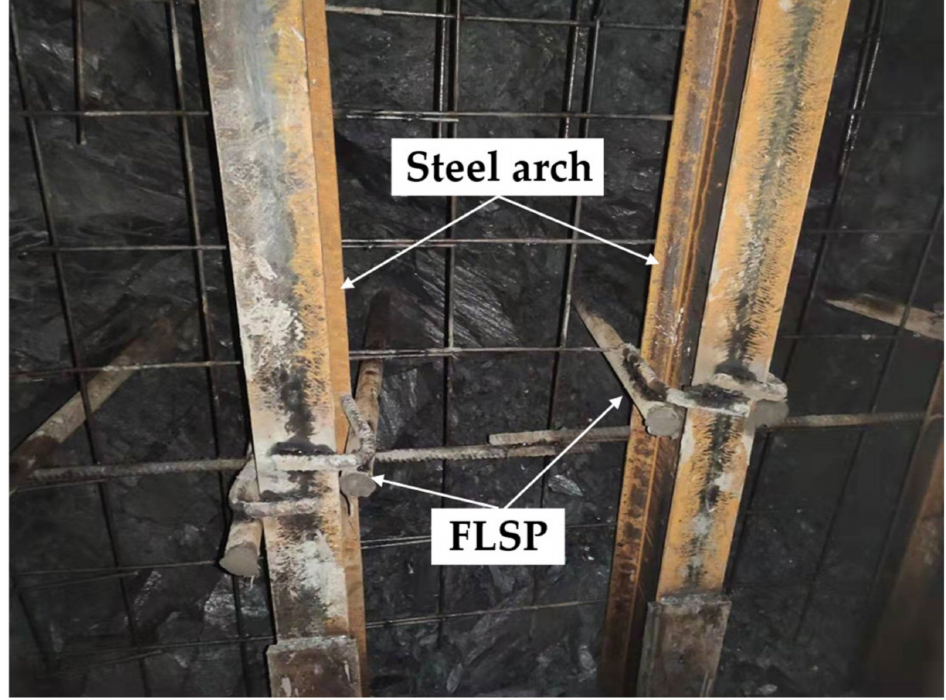
Figure 1. Feet-lock steel